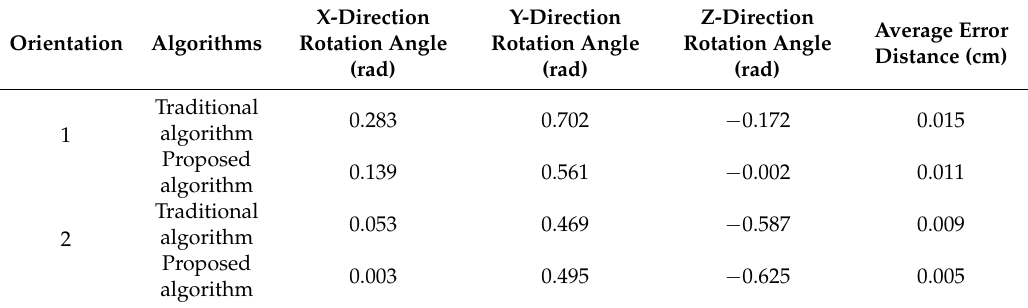
Table 6. Experimental results of different algorithms. Table 7. Comparison of average error distance and total registration time of multiple sets